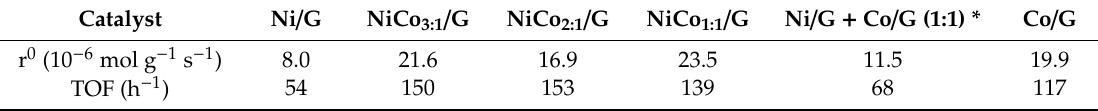
Table 2. Initial rate of guaiacol conversion and the turnover frequency (TOF) calculated for each catalyst. Catalyst Ni / G NiCo 3:1 / G NiCo 2:1 / G NiCo 1:1 / G Ni / G + Co / G (1:1) * Co / G 8.0 21.6 16.9 23.5 11.5 19.9 TOF (h − 1 ) 54 150 153 139 68 117 * Mechanical mixture of Ni / G and Co / G (1:1).